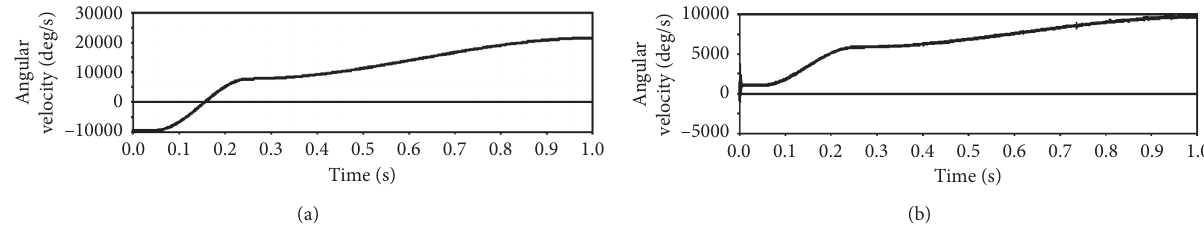
Figure 14: Angular velocity of shafts. (a) Angular velocity of the shaft of motor MG1. (b) Angular velocity of the engine shaft.